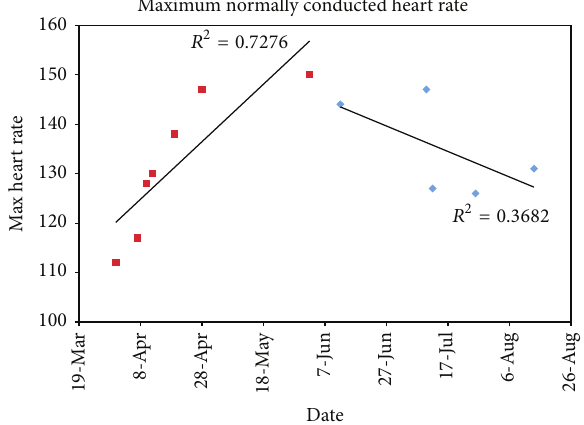
Figure 3: Plot of maximum normally conducted heart rates over time, demonstrating an increase in maximum rate with regular exercise training (red) and a decrease with nonadherence to regular training